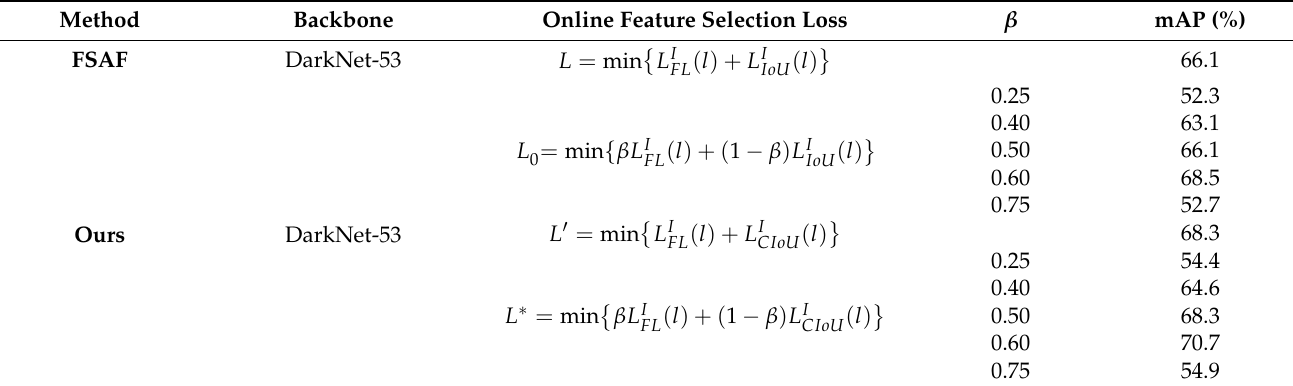
Table 1. Detection accuracy with different online feature selection losses on the experiment dataset. Method Backbone Online Feature Selection Loss β mAP (%) FSAF